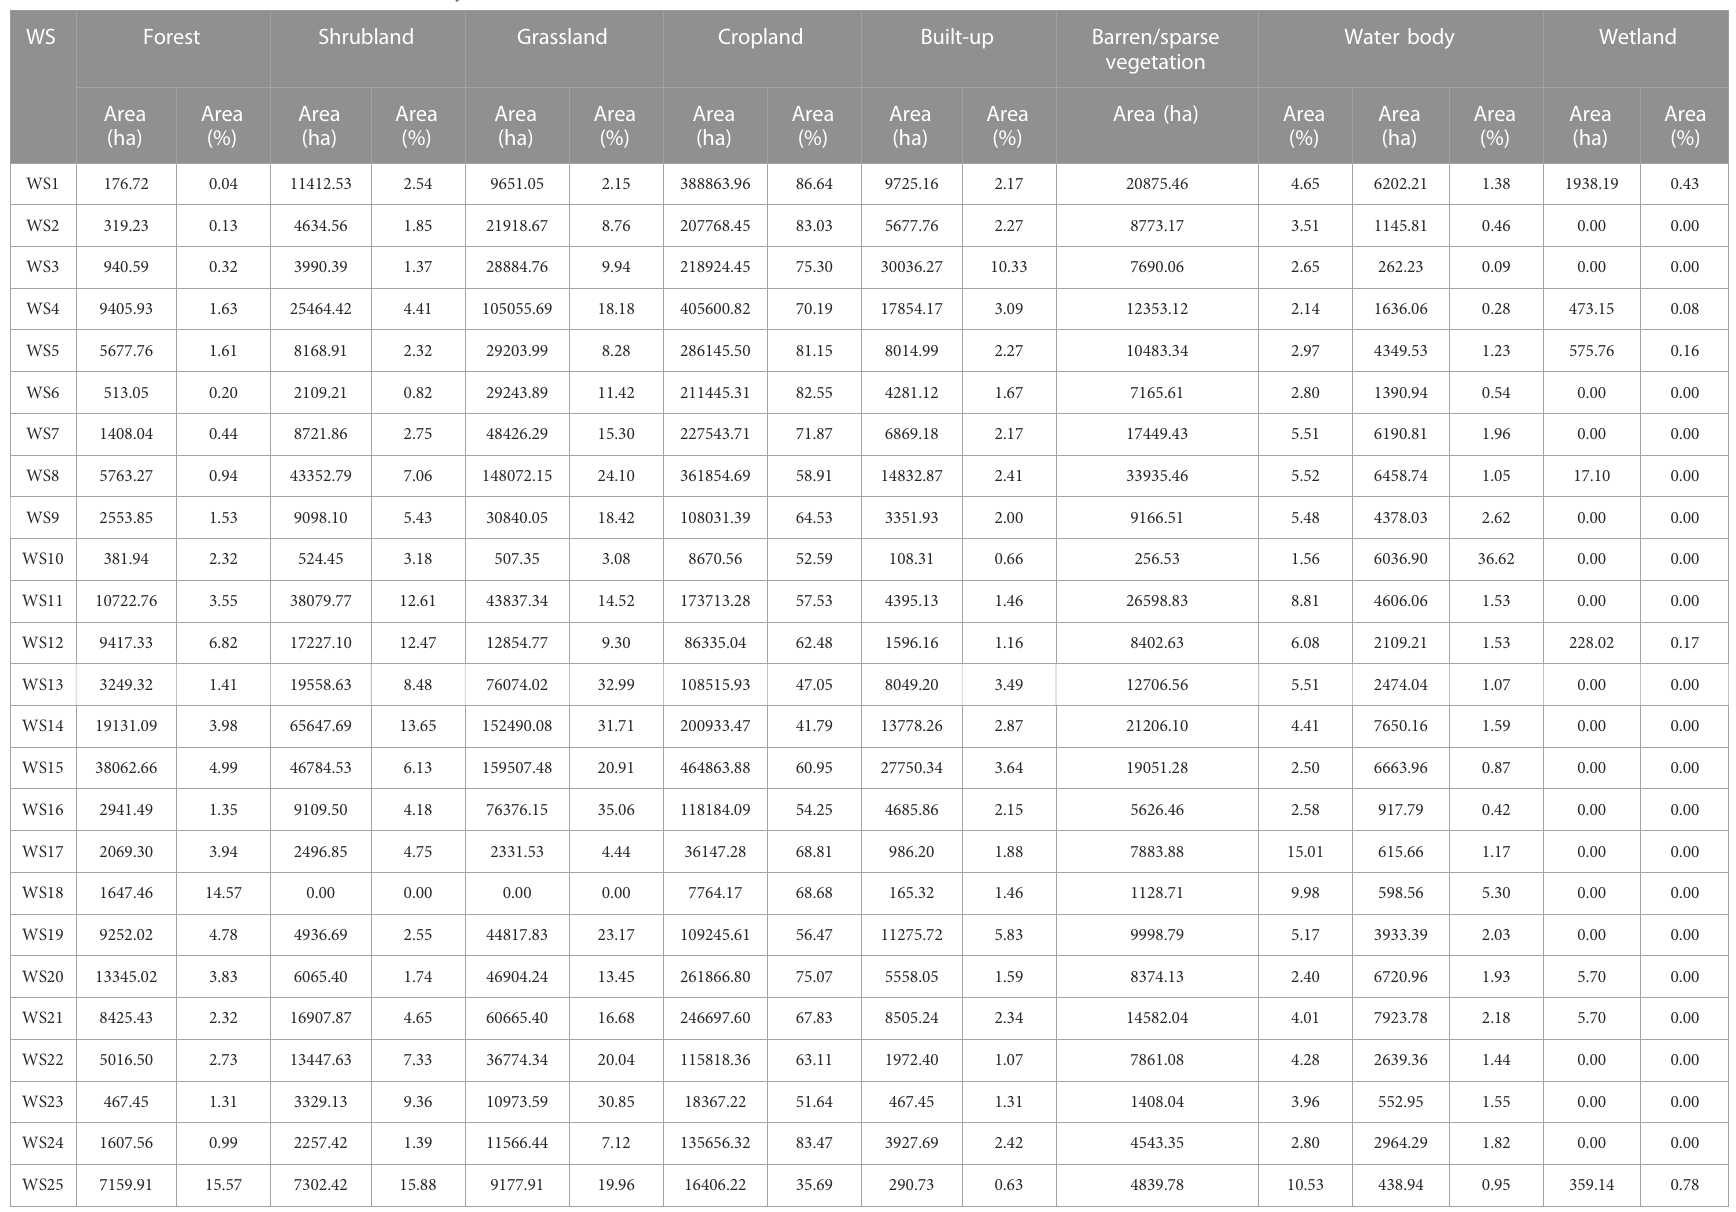
TABLE 3 LULC status in different watersheds in the study area. WS Forest Shrubland Grassland Cropland Built-up Barren/sparse